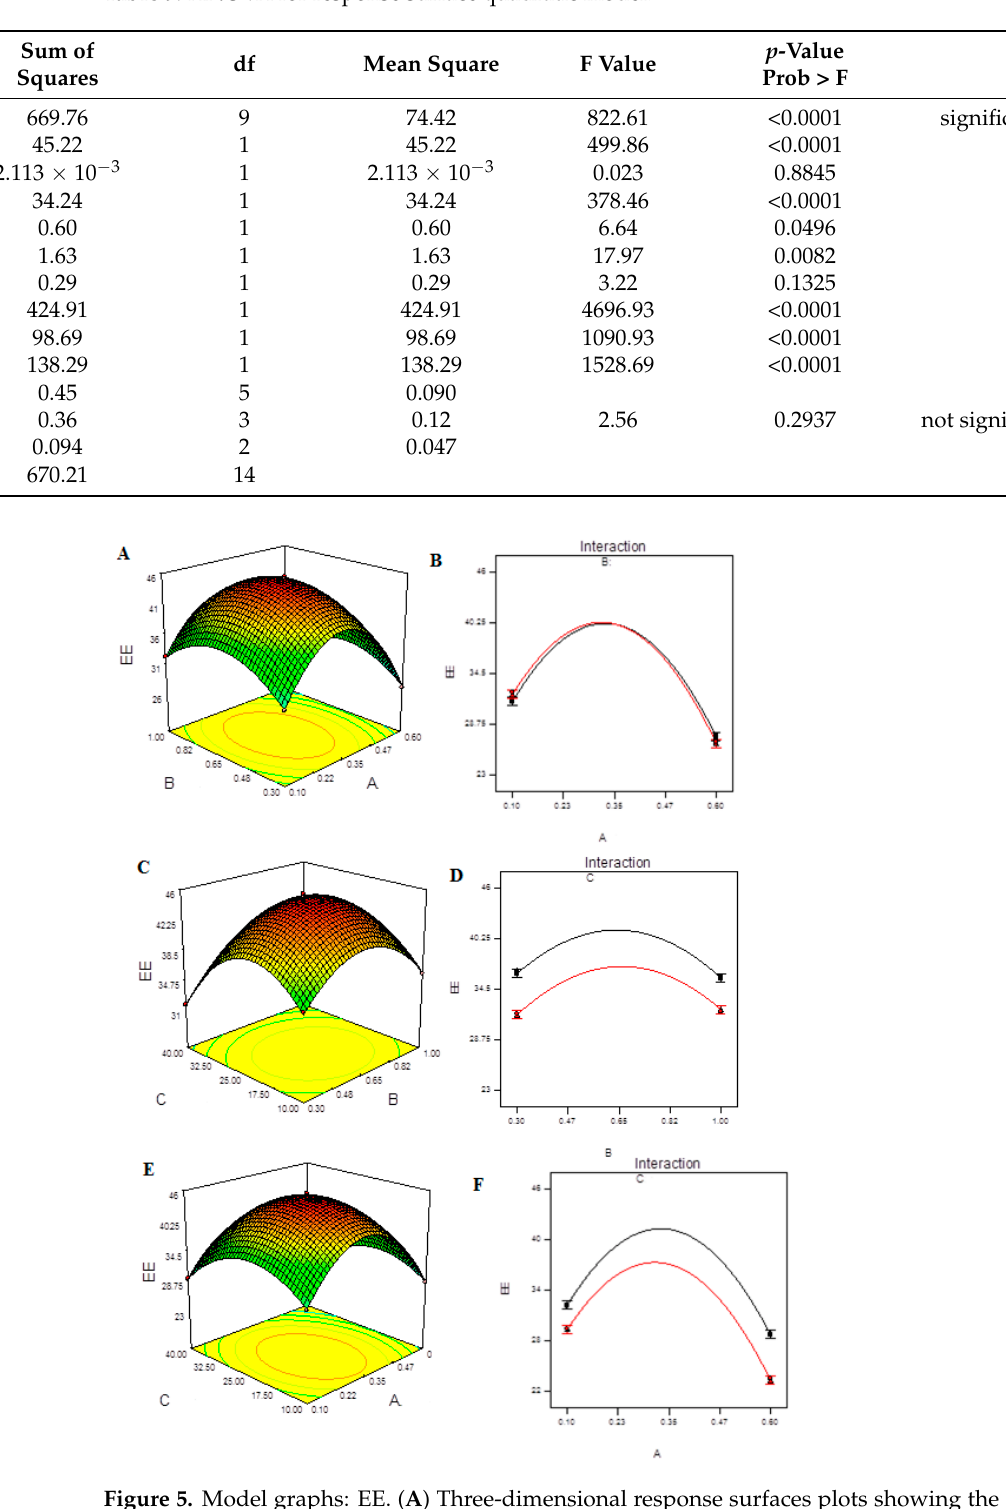
Table 9. ANOVA for response surface quadratic model.